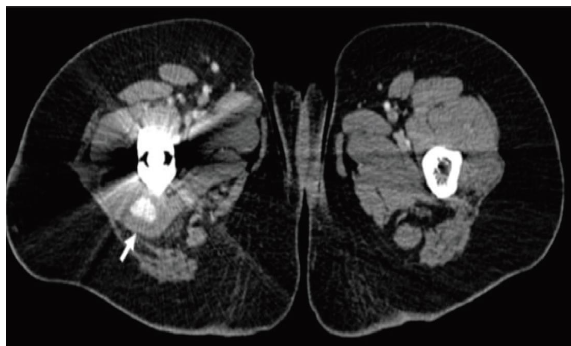
Figure 1: CT with contrast showing the right deep femoral artery